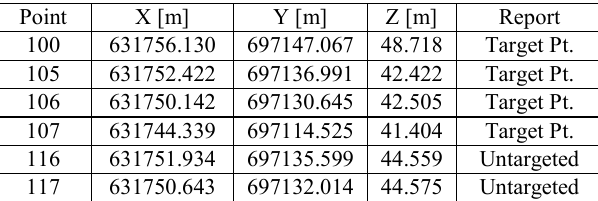
Table 1. The co-ordinates of control